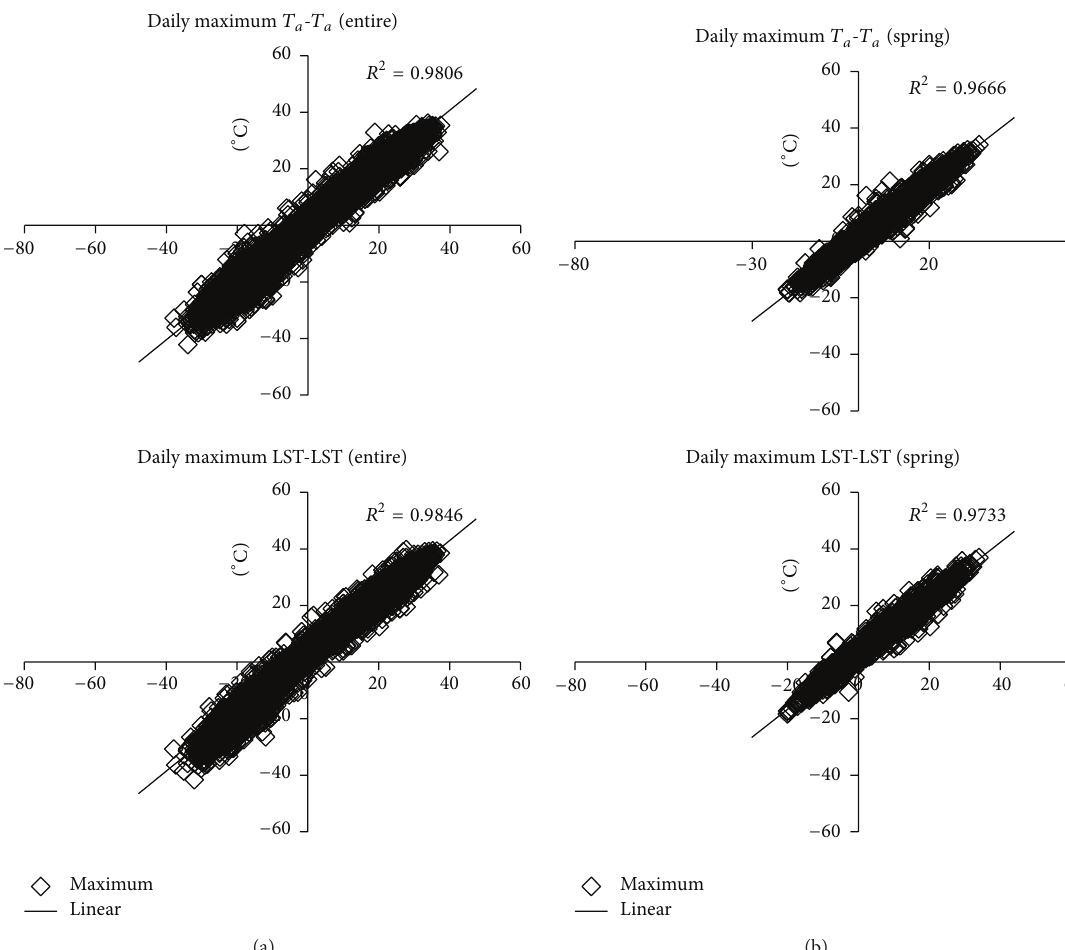
Figure 4: Scatter plot of daily maximum 𝑇 𝑎 creation results for 𝑇 𝑎 - 𝑇 𝑎 and LST-LST methods during the entire period (a) and spring (b), taking station pair 1-1 𝑁 as